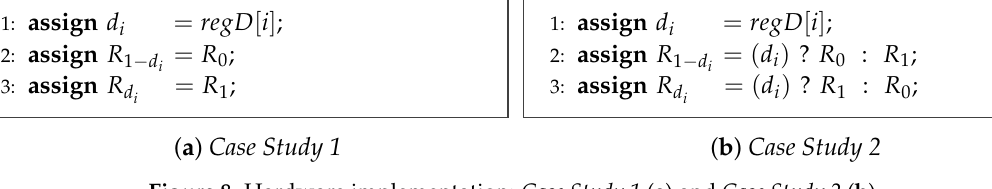
Figure 5. Hardware implementation: Case Study 1 (left) and Case Study 2 (right) Figure 8. Hardware implementation: Case Study 1 ( a ) and Case Study 2 ( b